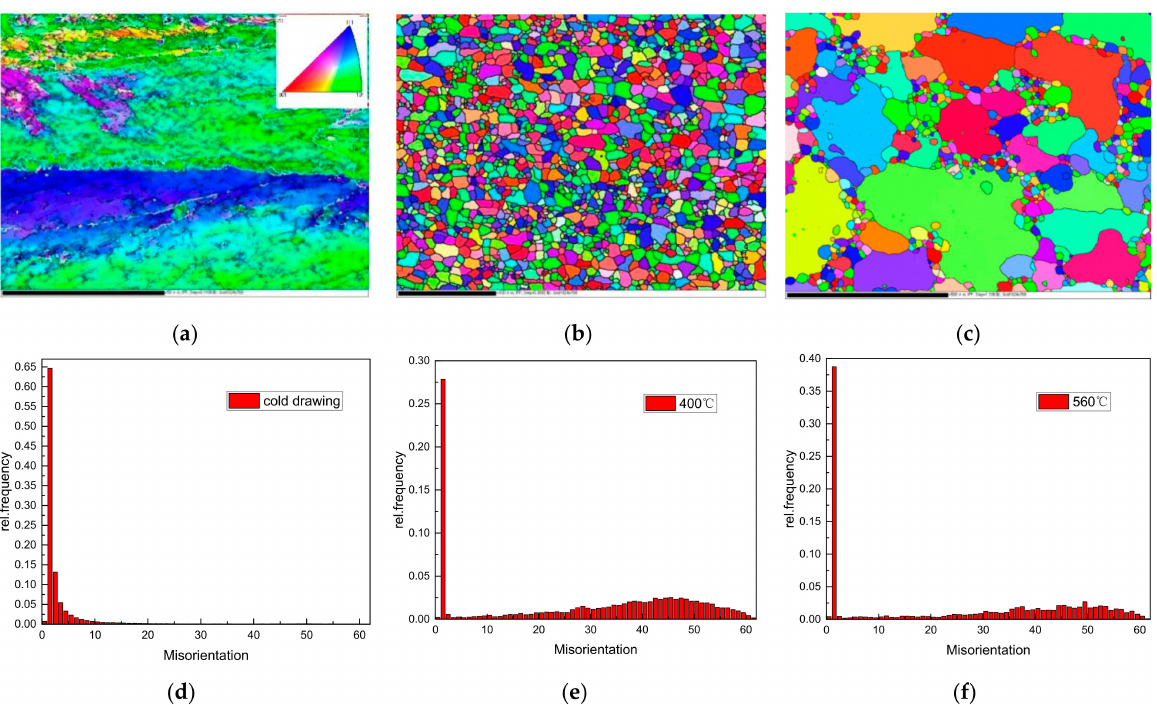
Figure 9. Curves and distribution of grain boundary misorientation angles after a 5056 aluminum alloy was annealed at different temperatures: ( a , d ) cold-drawn state; ( b , e ) 400 ◦ C; ( c , f ) 560 ◦ C. Figure 11 shows the orientation density of each texture under different conditions.